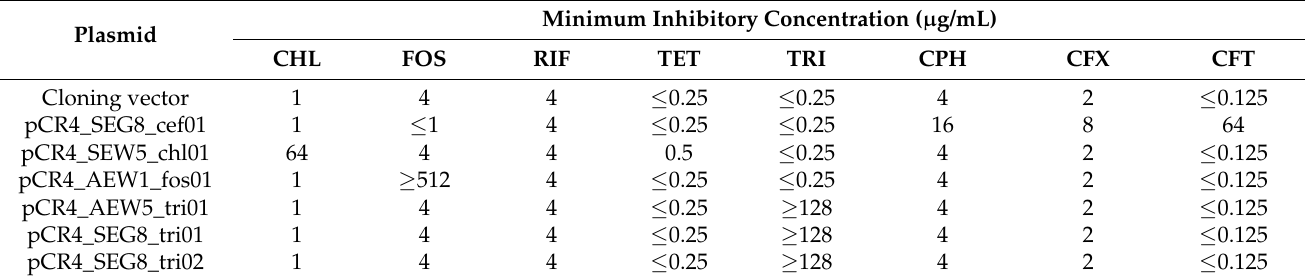
Table 3. Antibiotic susceptibility of E. coli harboring vector pCR4-TOPO without or with insert.